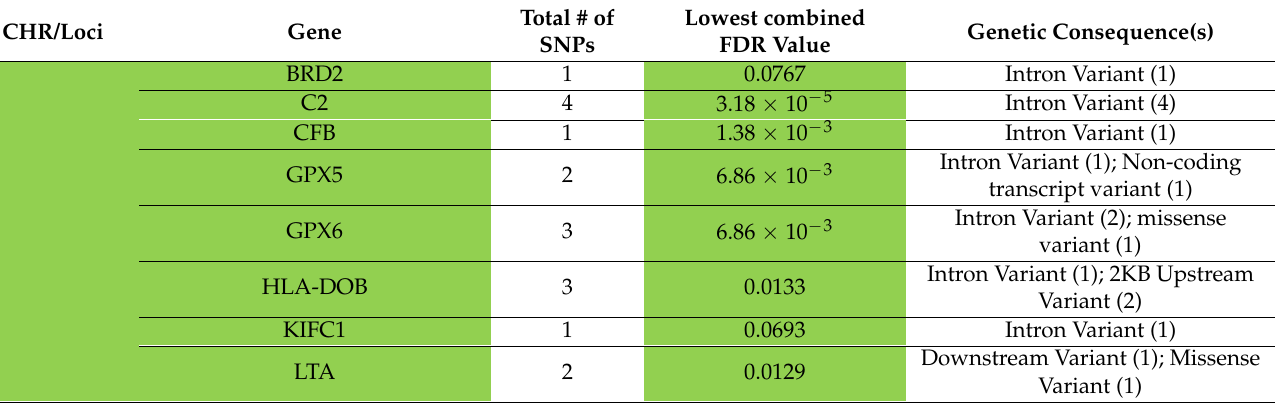
Table 4. Summary table for all the identified SNPs with a combined FDR value ≤ 0.1 and their associated genetic regions from the combined analysis. For all SNPs that corresponded to a gene, the total number of SNPs identified and a representative lowest combined FDR value (see appendix for full list) and genetic consequences (with the corresponding number of SNPs for that genetic consequence) is given. For SNPs that mapped to an intergenic region, the closest gene upstream and downstream has been indicated by INT(Gene1_Gene2) with the total number of SNPs and lowest representative combined FDR value. SNPs identified within genes for each loci are highlighted; HLA (green), NKC (orange) and LRC